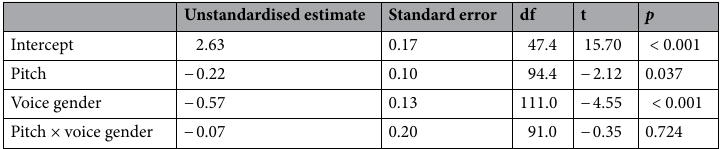
Unstandardised estimate Standard error